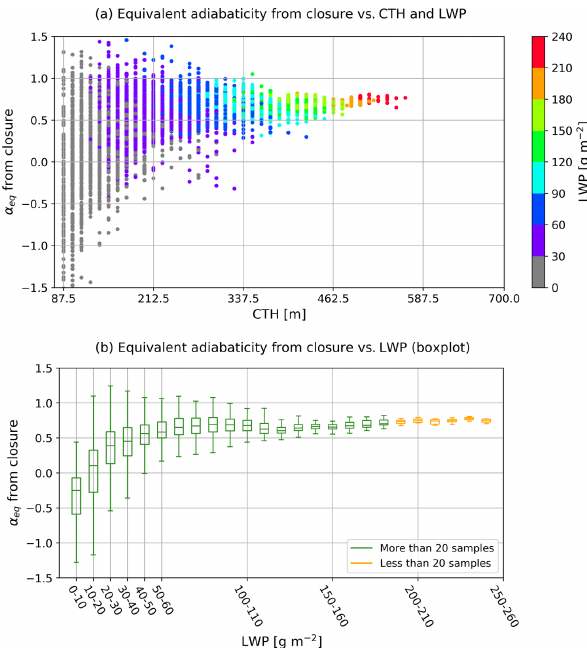
Figure 3. (a) Equivalent adiabaticity versus fog CTH and LWP. The equivalent adiabaticity is calculated by closure, using Eq. (6). (b) Boxplot of the equivalent adiabaticity, calculated by closure, for different LWP ranges. In both figures only samples with visibility below 2000m are considered.